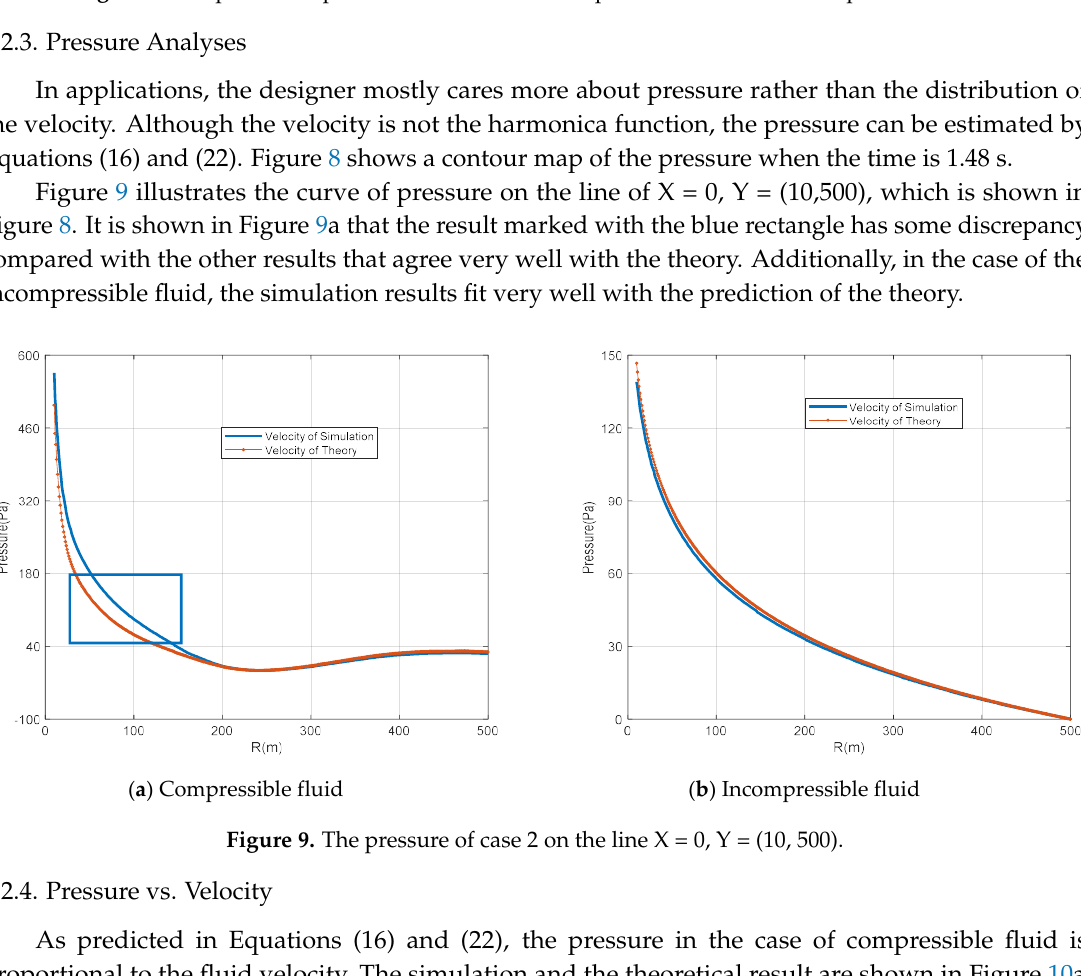
Figure 8. The plot of the pressure of case 2 with compressible fluid and incompressible fluid.